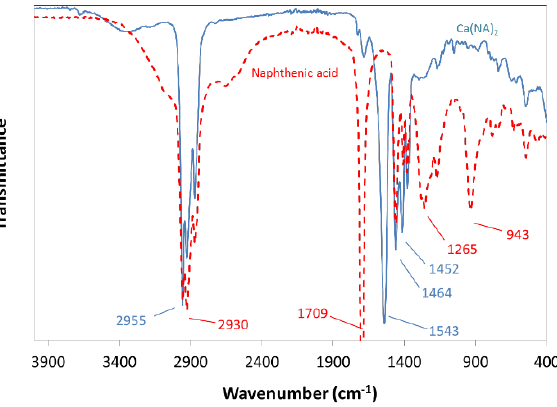
Figure 1. Attenuated Total Reflection (ATR)-infrared spectra of naphthenic acid (red, dashed) and its calcium salt (blue, continuous).